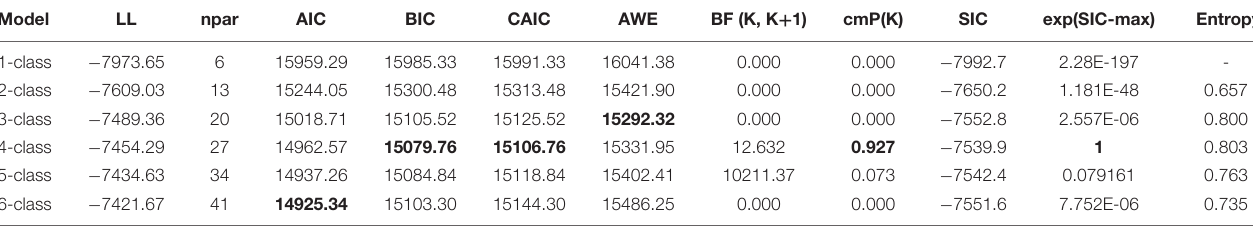
TABLE 1 | Latent class solution of student behaviors at the year